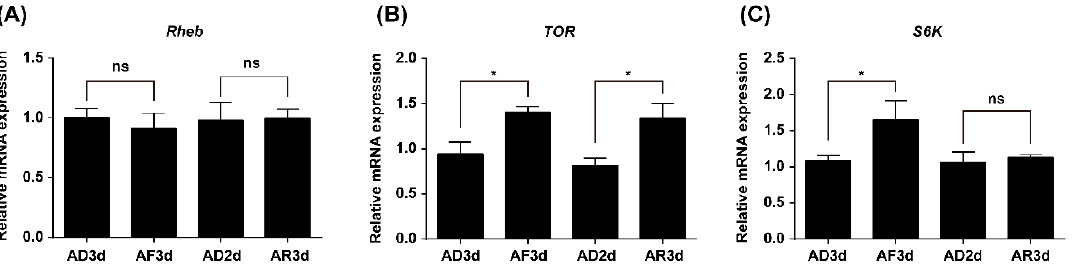
Figure 2. Relative mRNA levels of Rheb ( A ), TOR ( B ) and S6K ( C ) in the fat body of adult females upon different amino acid (AA) treatments. AD3d, newly emerged females were reared on artificial diets without AAs for three days continuously; AF3d, females were supplied with AAs for three days; AD2d, females were reared without AAs for two days; AR3d, females lacking AAs on the first and second day were supplied with AAs on the third day. Relative expression levels of Rheb , TOR and S6K mRNA in the fat body were detected by qRT-PCR using β -actin as a reference. Values were shown as mean ± SE of three independent experiments and asterisk denoted significant differences from controls (Student’s t -test, * denotes p < 0.05 and “ns” denotes p ≥ 0.05).